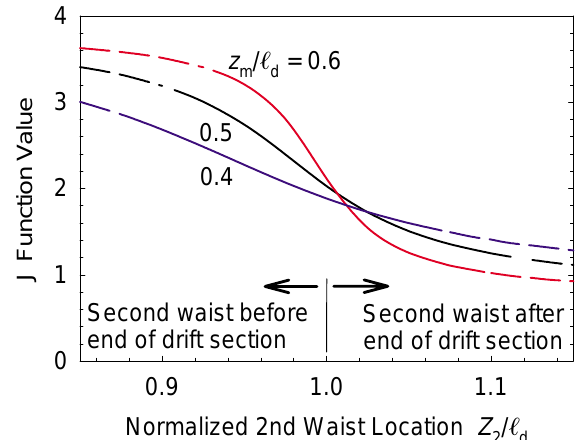
FIG. 2. Beam optics example in the drift space: ´ N (cid:1) 1 mm mrad, g (cid:1) 88 , L d (cid:1) 2 m, z w 1 (cid:1) 2 0.235 m, z T (cid:1) 1.0 m, and z w 2 (cid:1) 2.0 m.